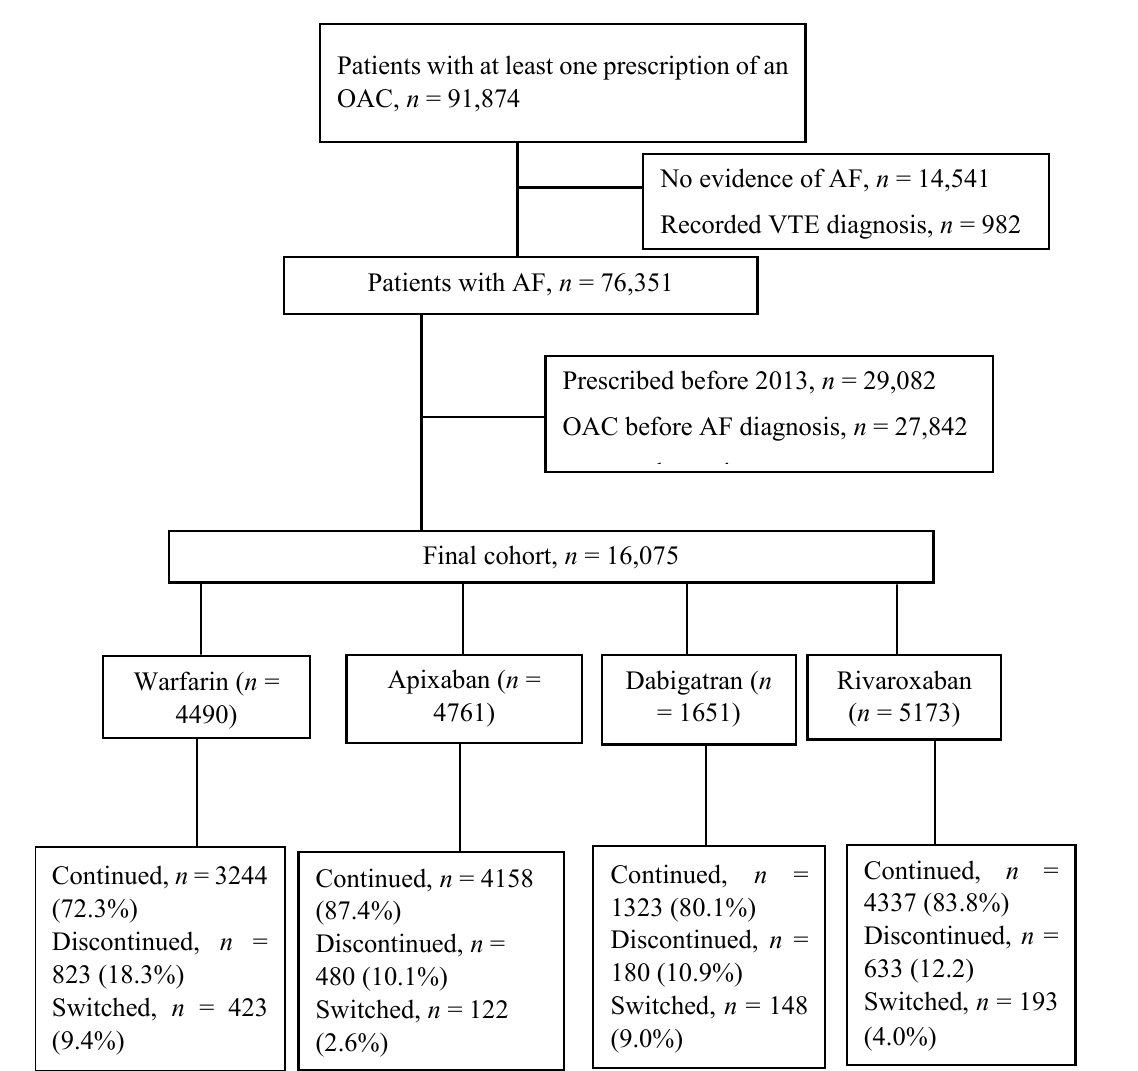
Figure 1. Flowchart of the cohort selection process (AF: atrial fibrillation, OAC: oral anticoagulant; VTE: venous thromboembolism).